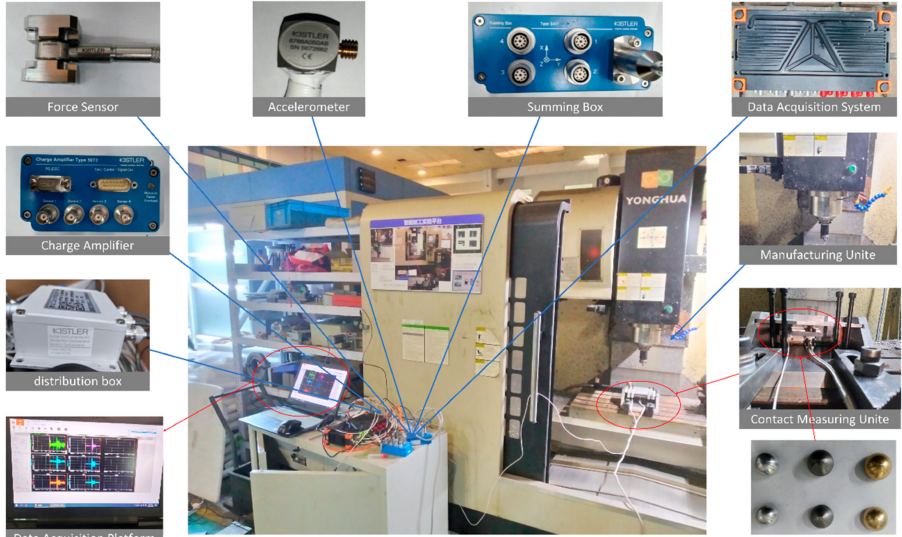
Figure 2. The experiment setup used in the tangential contact stiffness